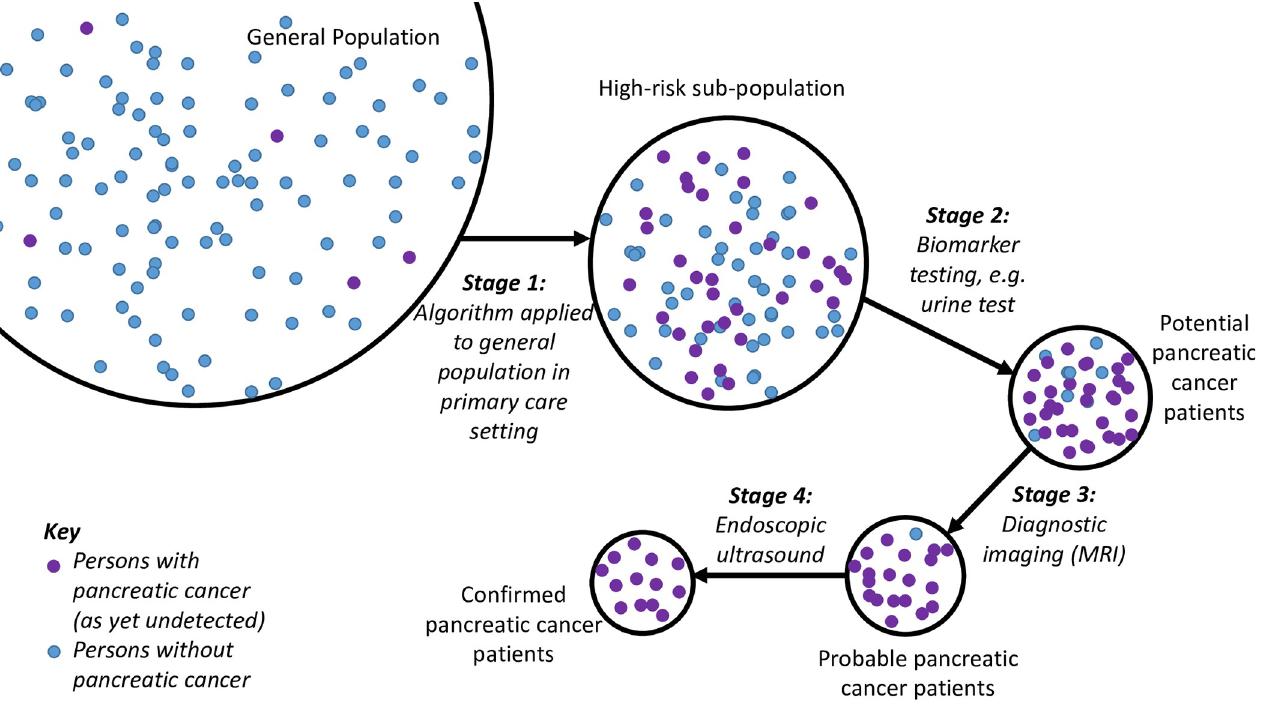
Fig 1. Schematic of multi-stage screening process starting with machine-learning derived algorithm.